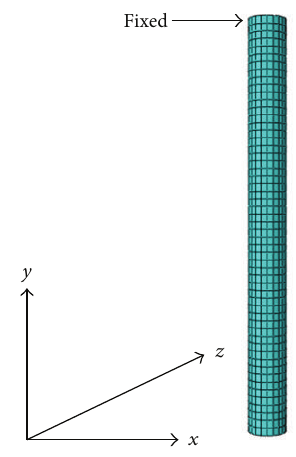
Figure 4: ABAQUS meshed model of